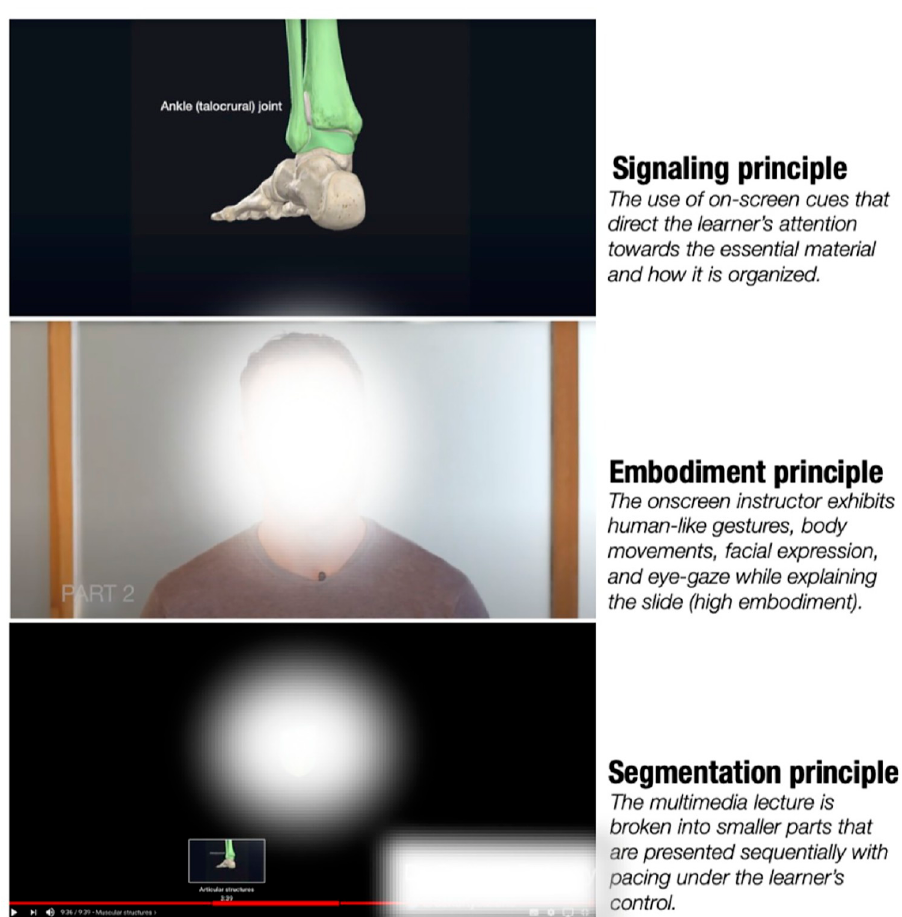
Fig 1. An example of the signalling, embodiment and segmentation principles for one of the multimedia lectures included in the analysis that related to the functional anatomy of the ankle